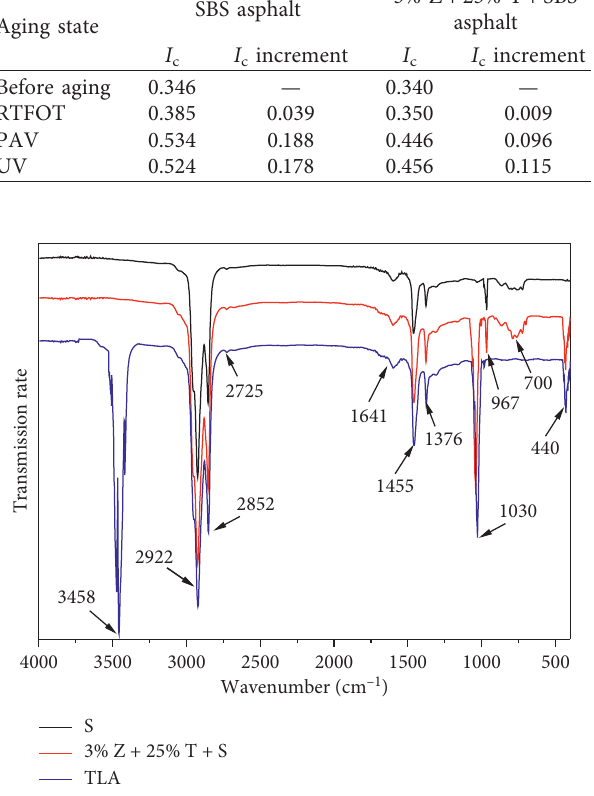
Figure 9: Effect of nano-ZnO (Z) and TLA (T) on infrared spectrum of SBS asphalt